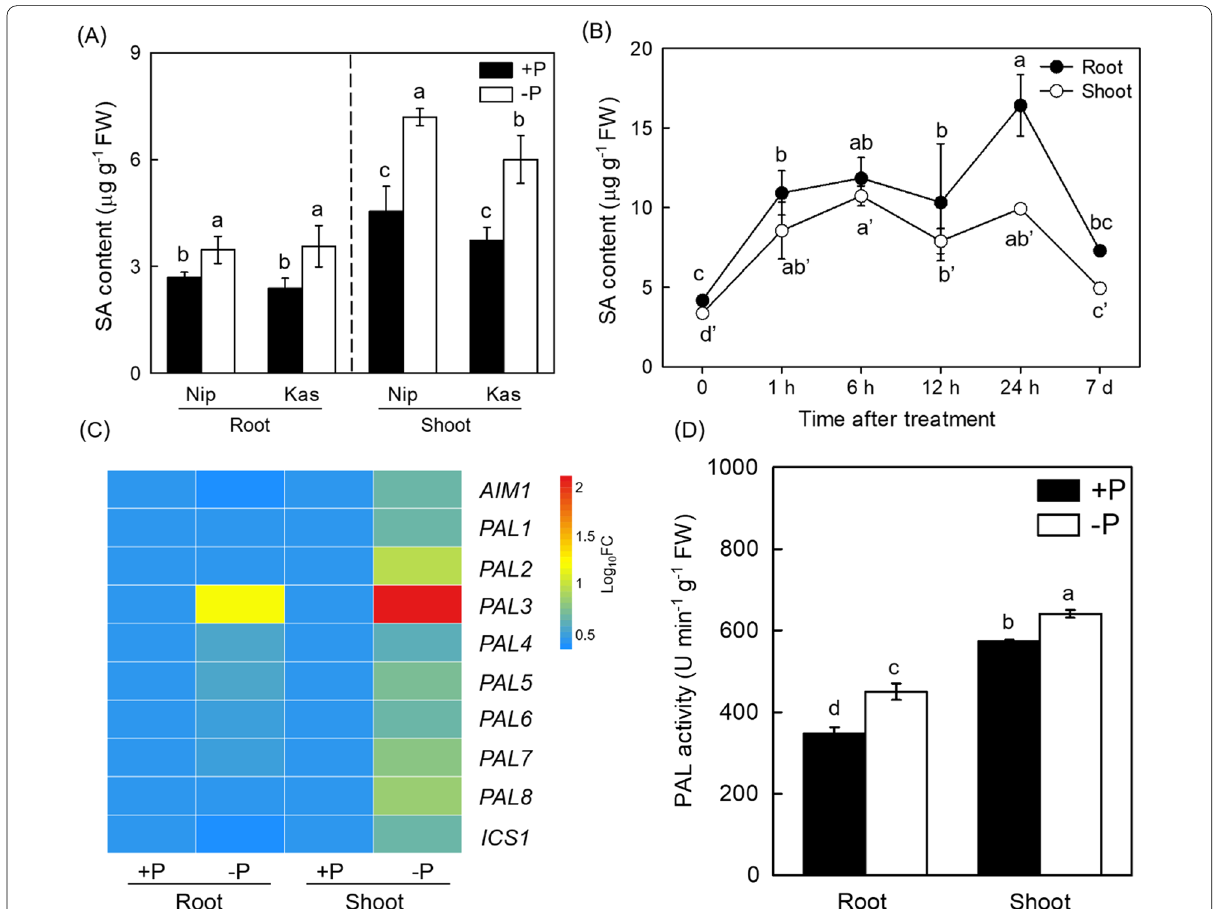
Fig. 1 P deficiency activates SA accumulation in rice. Root and shoot SA content ( A and B ), SA biosynthetic genes expression ( C ) and PAL activity ( D ) under –P treatment for 7 d in rice were measured. Data are means multiple range test at the P <